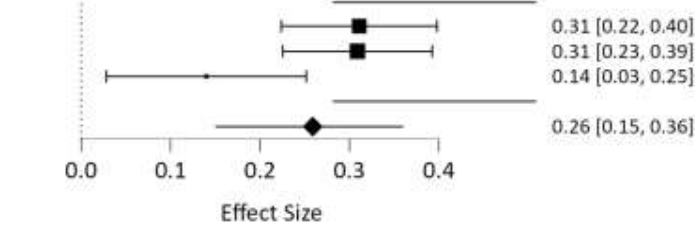
Figure 25. Forest plot of meta-analysis of Motivation for knowledge and L2 test success